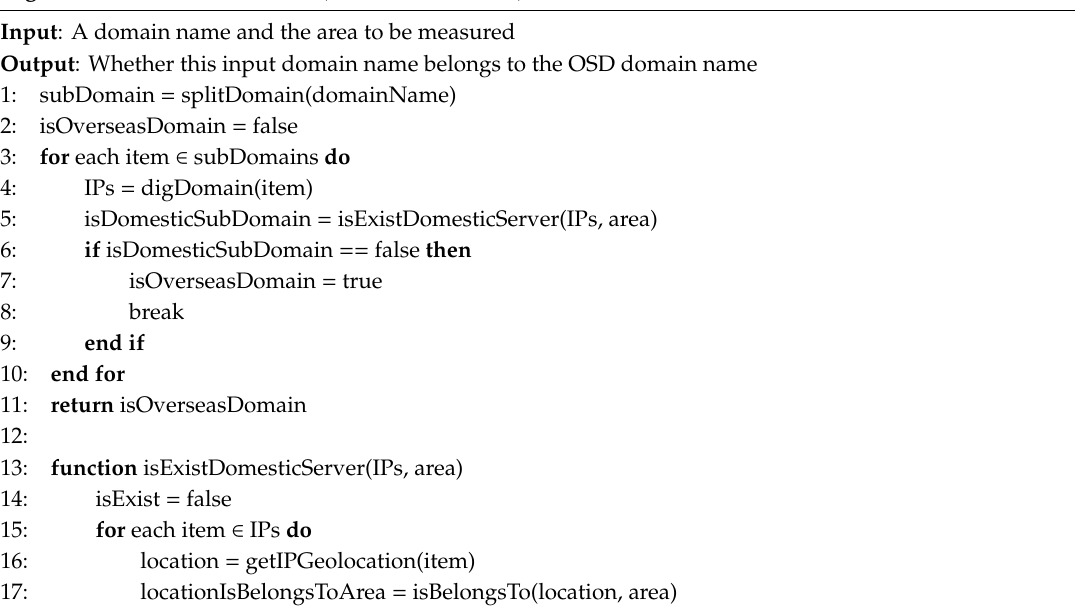
Algorithm 1 OSD Identification (domainName,